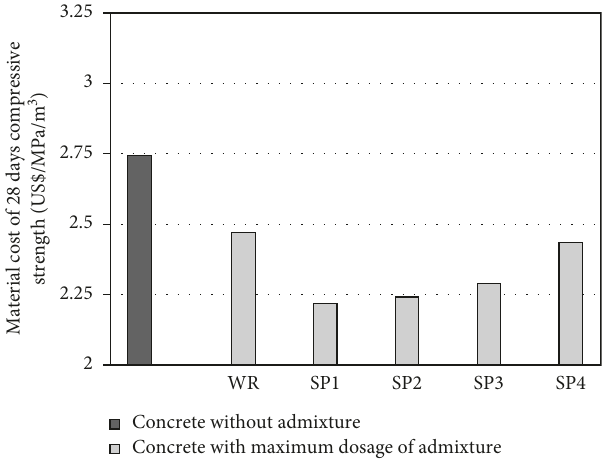
Figure 8: Unit strength costs of 1 m 3 of concretes (W/C (cid:31) 0.40, s/a (cid:31) 0.40, and C (cid:31) 340 kg/m 3 ) prepared with maximum recom- mended dosages of different types of chemical